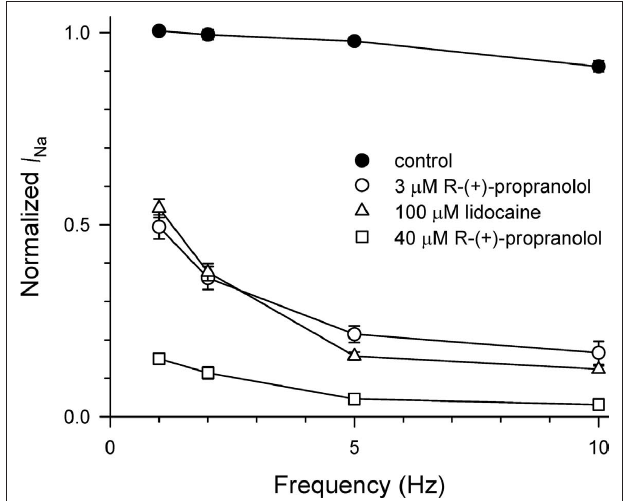
Figure 4 | use-dependent block of Na 1.5 by propranolol and lidocaine. V Steady-state use-dependent inhibition of Na 1.5 by 100 μM lidocaine, 3 and V 40 μM R-( + )-propranolol at 1, 2, 5, and 10 Hz pulsing frequencies. The data are averaged peak currents following the 100th pulse in the presence of drug normalized to peak current measured in the absence of drug. Each point represents mean ± SEM from 7 to 14 cells.